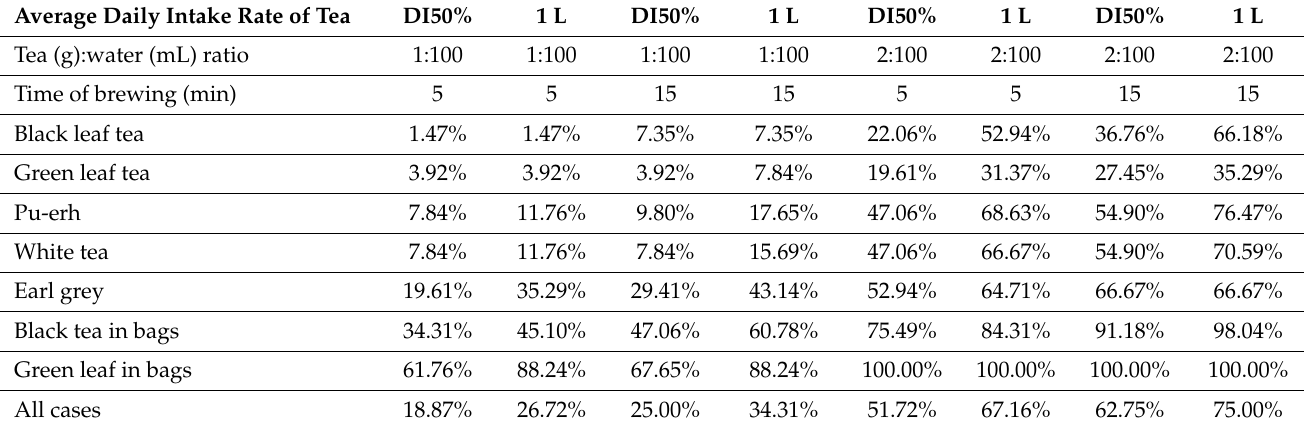
Table 4. The percentage share of analyzed cases for which the THQ parameter exceeded the value of 1. The THQ parameter was determined based on the results of the study by Szmagara et al. [39] obtained under the brewing conditions presented in the